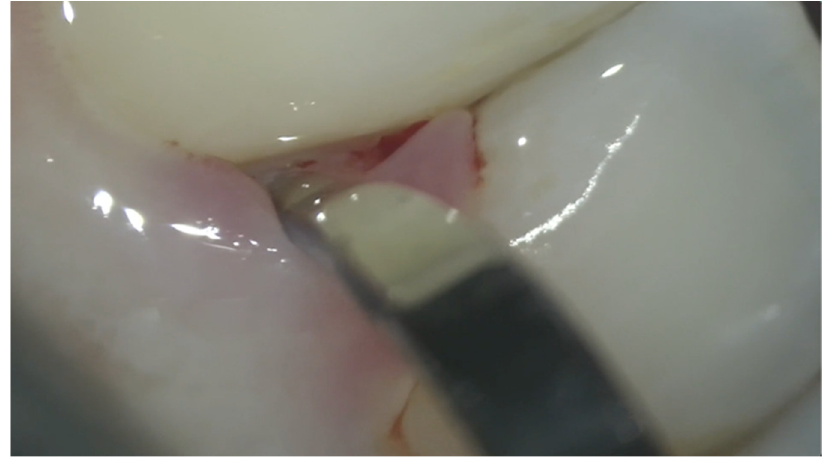
Figure 2. Visualization of negative recession using an operating microscope with magnification (10×) and co-axial illumination during ultrasonic scaling (Supplemental Video).